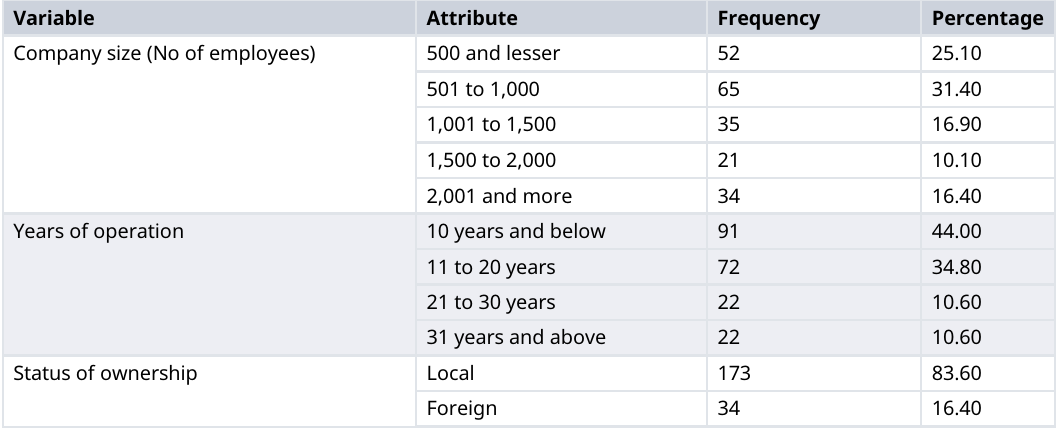
Table 1. Profile of responding